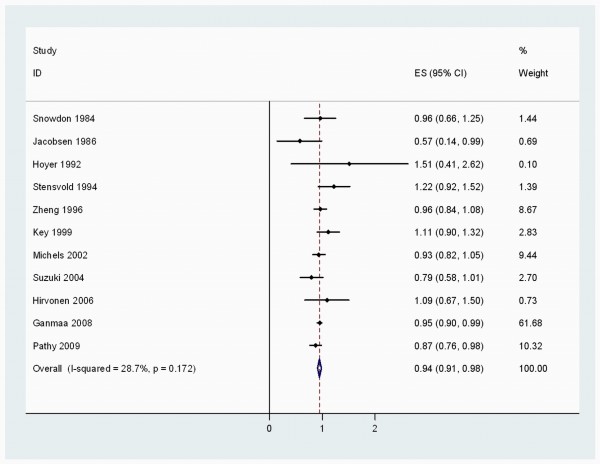
Summary RRs of breast cancer for low to moderate coffee drinkers versus non/lowest drinkers from included studies. Squares represent study-specific relative risk estimates (size of the square reflects the study-specific statistical weight, that is, the inverse of the variance); horizontal lines represent 95% CIs; diamonds represent summary relative risk estimates with corresponding 95% CIs.